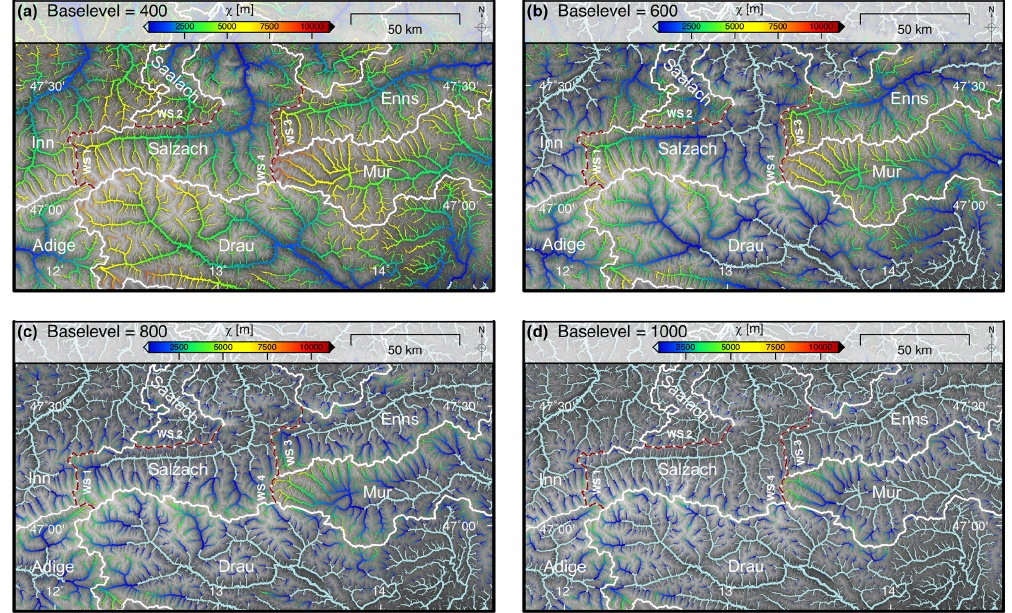
Figure 2. Drainage pattern of the Eastern Alps calculated for increasing base levels and colour-coded for χ . All streams with a contributing drainage area larger than 1km 2 are shown. The line width of the channels is proportional to log 10 (drainage area). White lines and annotations represent the major drainage divides. (a) Base level set to 400m of elevation. (b) Base level set to 600m of elevation. (c) Base level set to 800m of elevation. (d) Base level set to 1000m of elevation.